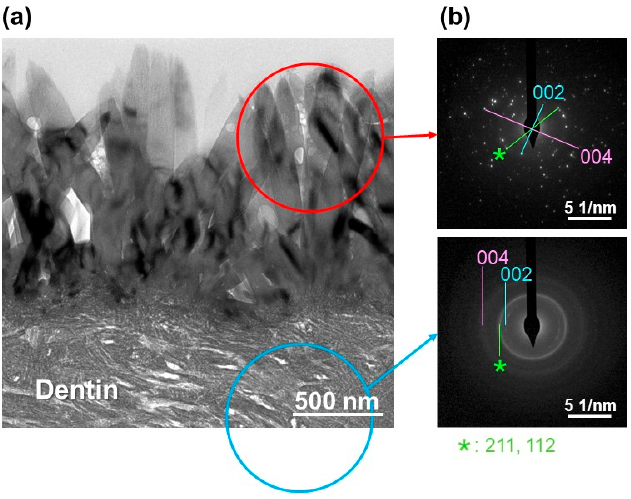
Figure 7. ( a ) Cross-sectional TEM image of the surface of the LAB-processed substrate ICG3W, and ( b ) SAED patterns obtained from the circled regions in ( a ). * in ( b ) corresponds to apatite 211 and 112 diffraction spots or rings.